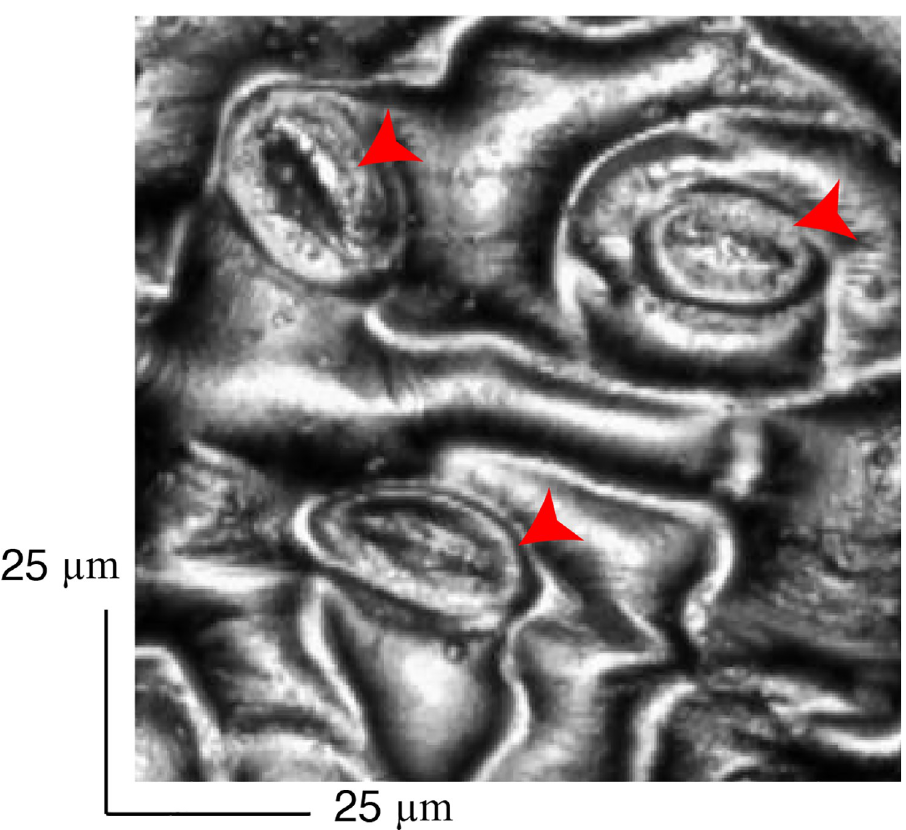
Fig 9. A typical observation of the rear part of the leaf with the laser scanning microscope. The red arrowheads indicate the elliptically shaped